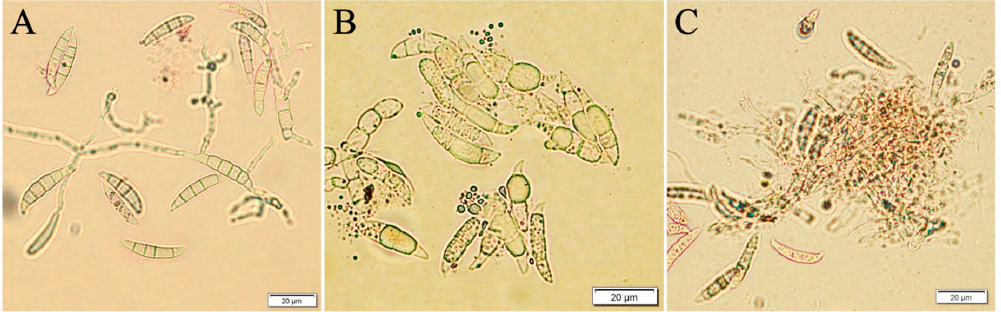
Figure 7. Degradation of F. culmorum Fc37 macroconidia in W.E: ( B ) on the example of Fc37 W.E 0.2%; ( C ) Fc37 W.E 1.0% in a comparison to ( A ) water control (W.C), 96 h of incubation.